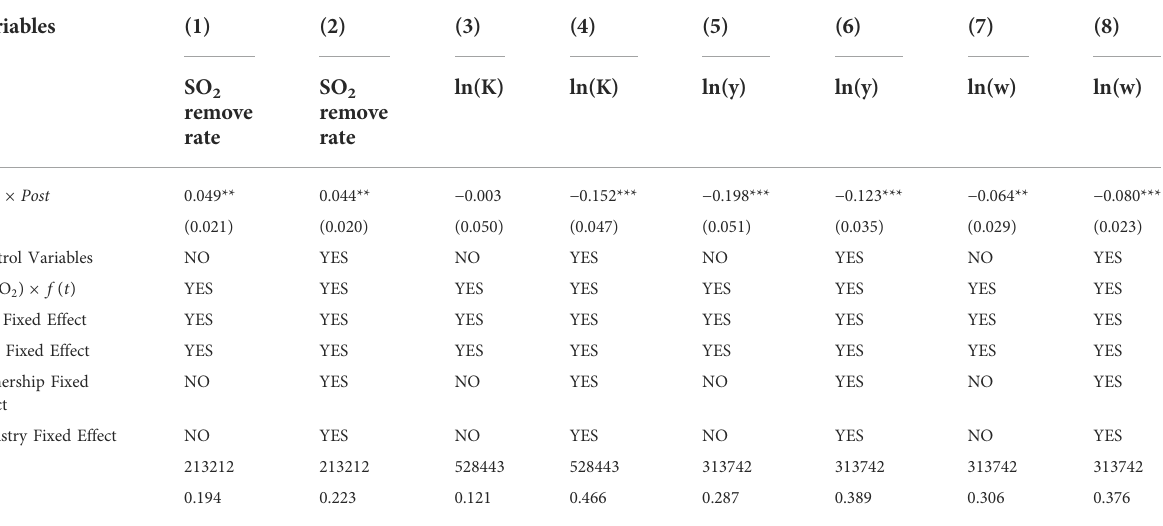
TABLE 6 Mechanism check: “ end-of-pipe ”